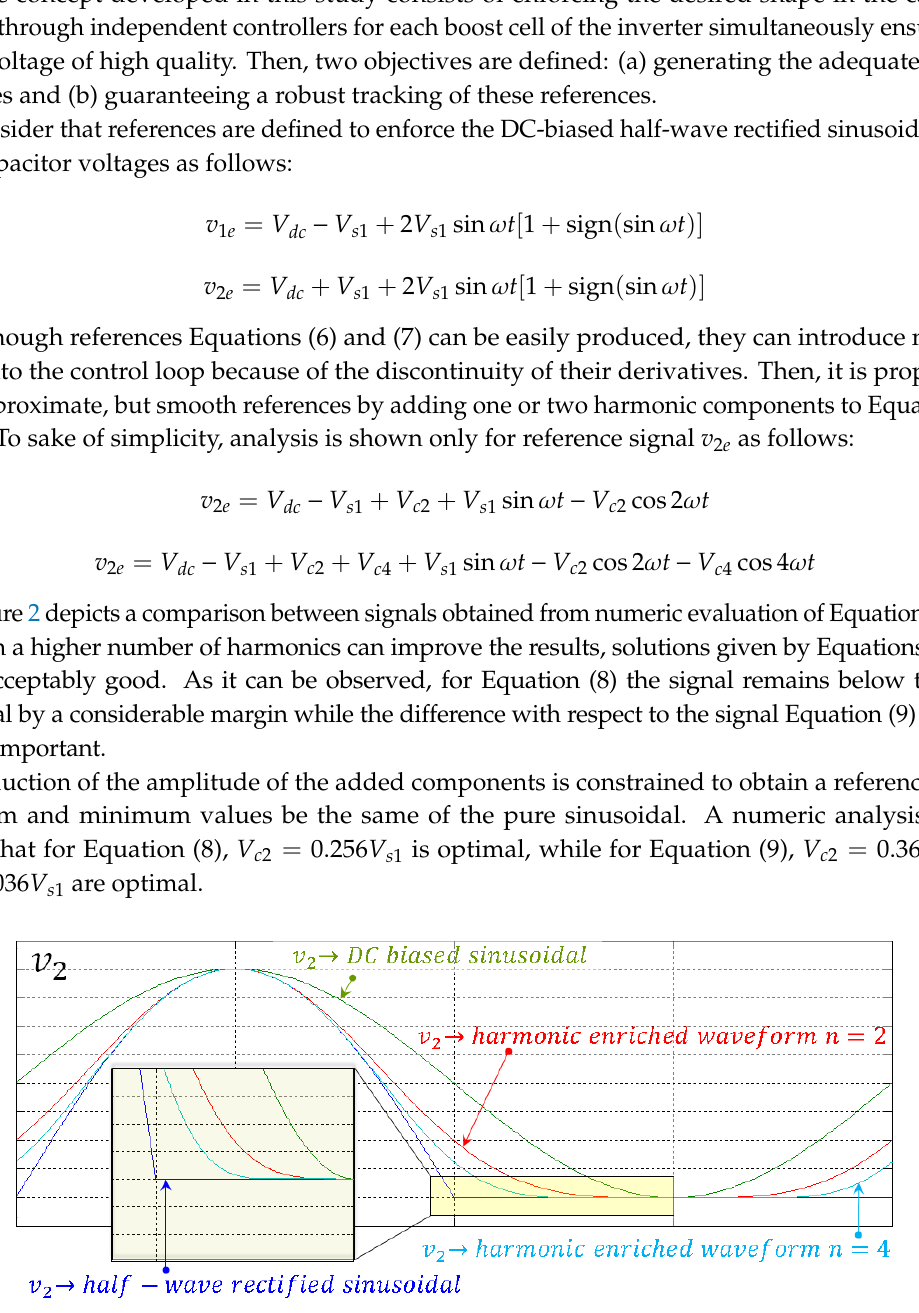
Figure 2. Comparison of possible waveforms for 𝑣 2 constraining the voltage excursion.